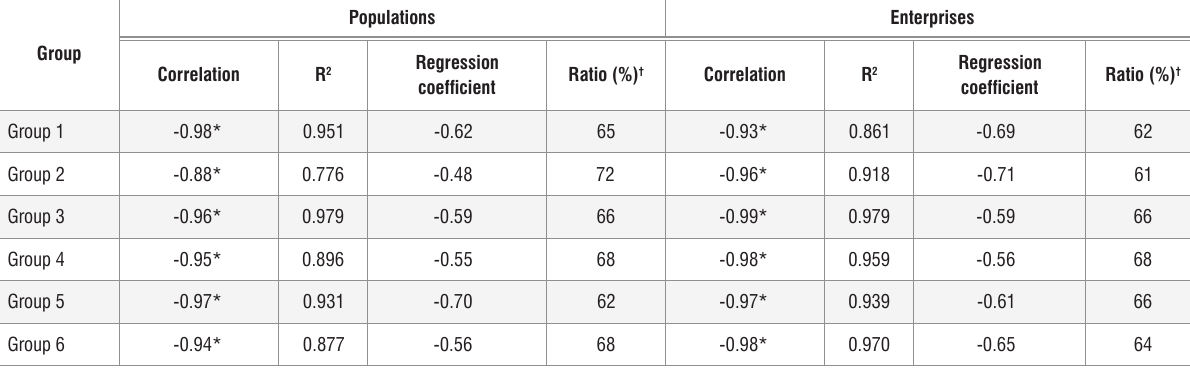
The rank-size distributions of populations and enterprise numbers of six groups of 15 towns each randomly selected from a large database Populations Enterprises Group Regression Correlation R 2 Ratio (%) coefficient